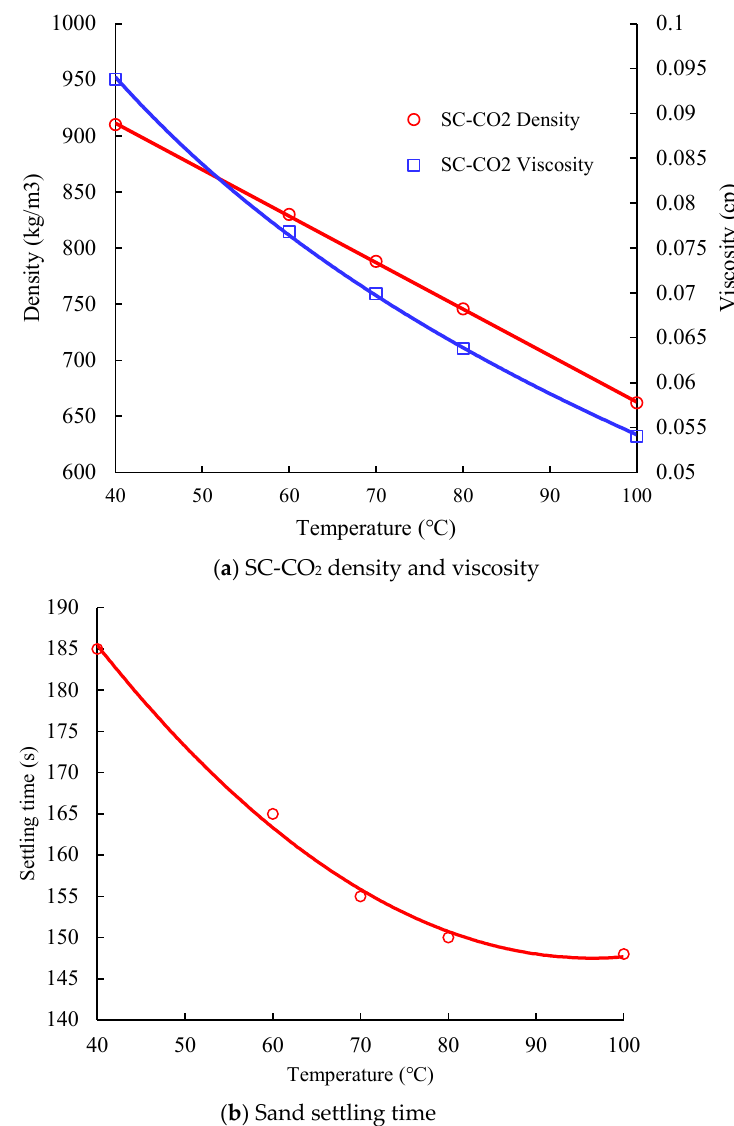
Figure 12. SC-CO 2 physical properties and sand settling time at different flow temperatures.